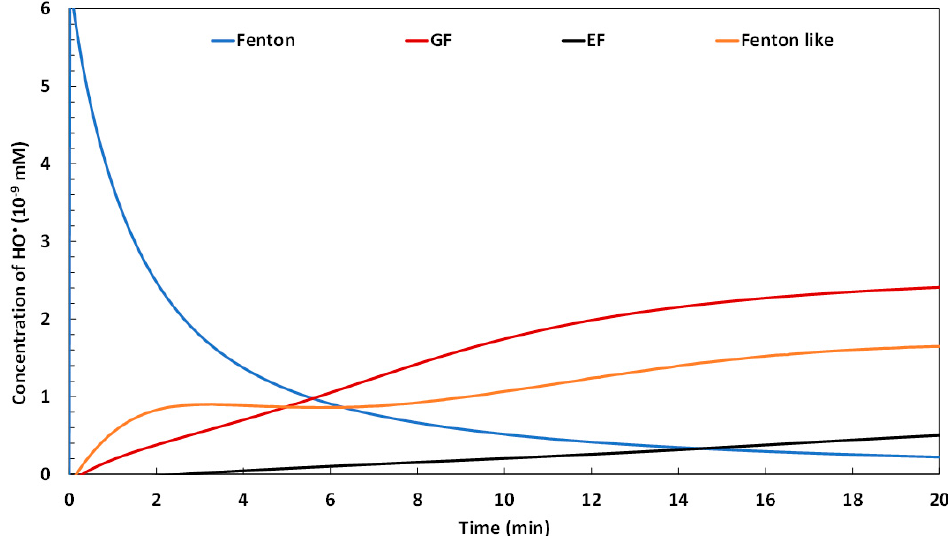
Figure 3. Evolutions of HO • concentration in a function of time with classic Fenton, Fenton-like, electro-Fenton, and Galvano-Fenton processes in the presence of phenol at 2 µM.